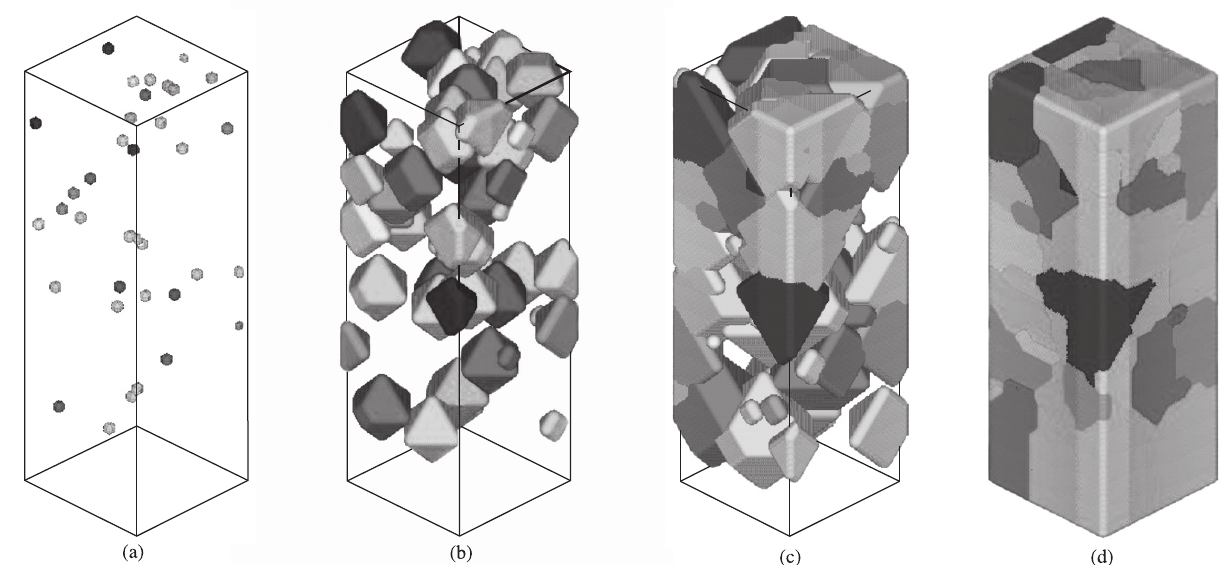
Figure 3. 3-d view of the simulated microstructures a) V